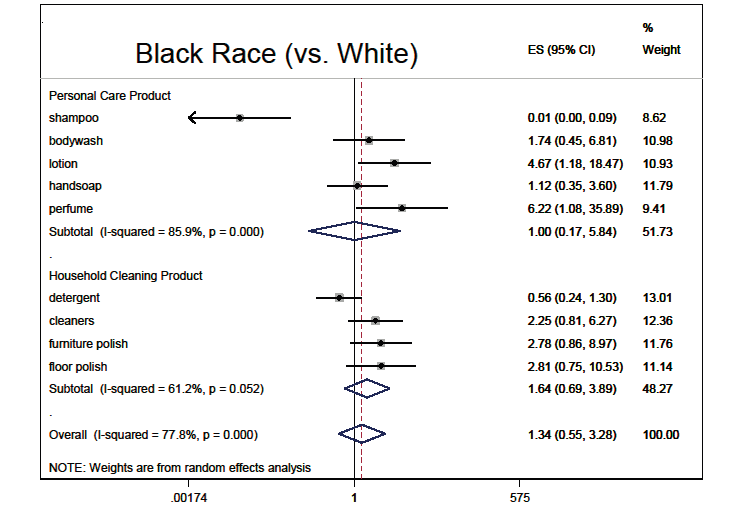
Figure 6. Demographic predictors of fragranced product use (meta-analysis of multivariable model results): black race ( vs. white). Models are ordered logistic regressions with random intercepts for twin pair and address, with fixed effects for age, sex, education, ever being bothered by fragrance and race, among black and white participants ( N = 314). Missing data were imputed by multiple imputation with chained equations. Model estimates are combined by random-effects meta-analysis by product